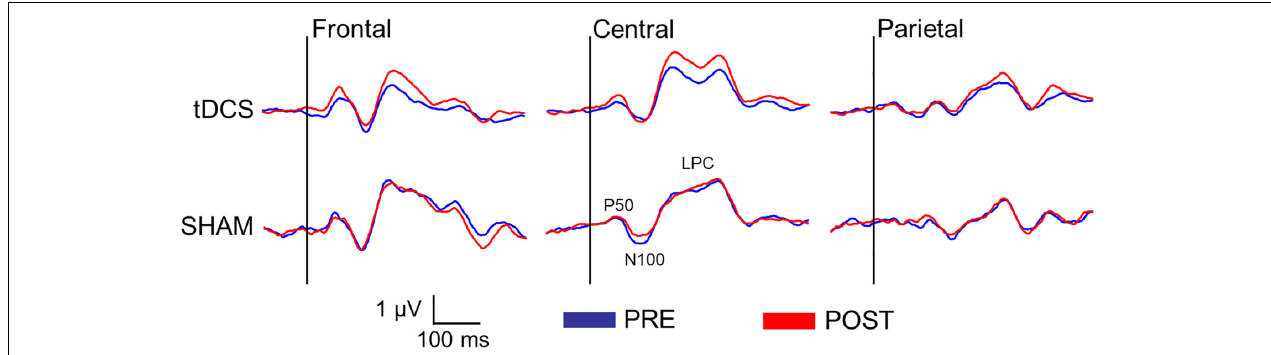
FIGURE 3 | Difference waveforms (S1 minus S2) before and after the intervention in both groups (tDCS vs. SHAM) at three regions of interest (ROI) (frontal: Fz, F3, F4; central: Cz, C3, C4; and parietal: Pz, P3, P4) representing the sensory gating of the somatosensory evoked potentials (SEPs).